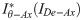
Near-optimal motion representation with GJs.(A) Near optimal motion representation for natural stimuli due to GJs by both triplets of VS cells (blue cross) and by the whole VS network (blue dot). The efficiency of the representation for a subpopulation is denoted by a single point in the IDe−Ax − Iθ−Ax plane, which shows how much information (in bits) corresponds to the neural cost and how much information is provided at this cost to represent the axis of rotation. This plane shows the feasible (blue region) and infeasible (white region) separated by the bound Iθ−Ax*(IDe−Ax), dark blue line (see Materials and Methods) for all axes of rotation of natural stimuli. The error bars depicting encoding efficiencies for triplets with/without GJs (blue vs. orange, respectively). Single cells with/without GJs appear in green/yellow squares, respectively (all 20 individual VS cells behaved very similarly to each other). The encoding efficiency of the whole VS network with/without GJs is shown in blue/orange circles. (B) The scatterplot of efficiencies for representations of all 120 triplets (all possible triplets out of the 10 VS cells; the same triplets were used in both sides of the visual system), with/without GJs (blue/orange respectively). The arrows point to VS5-6-7, the triplet connecting downstream to the neck motor center. Note the considerable improvement in efficiency due to GJs for this triplet. (C) Similar to (A), but for checkerboard stimuli. (D) Similar to (B), but for checkerboard stimuli.